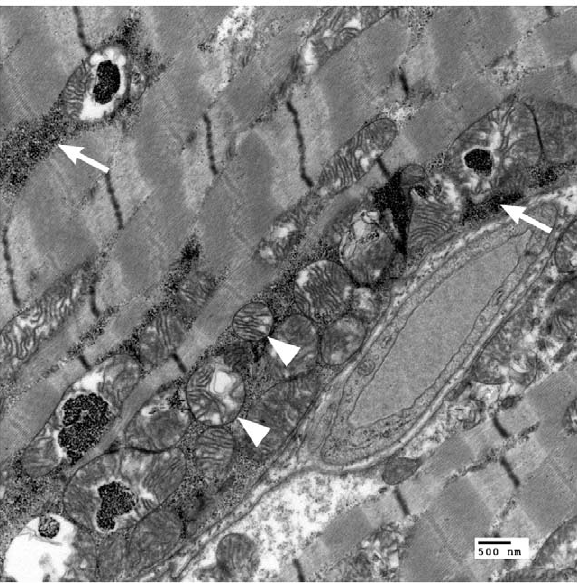
Figure 4. Fixed muscle (dog # 4). Transmission electron microsco- py. Glycogen deposits (arrowhead) are present in the abnormal megamitochondria (arrow).